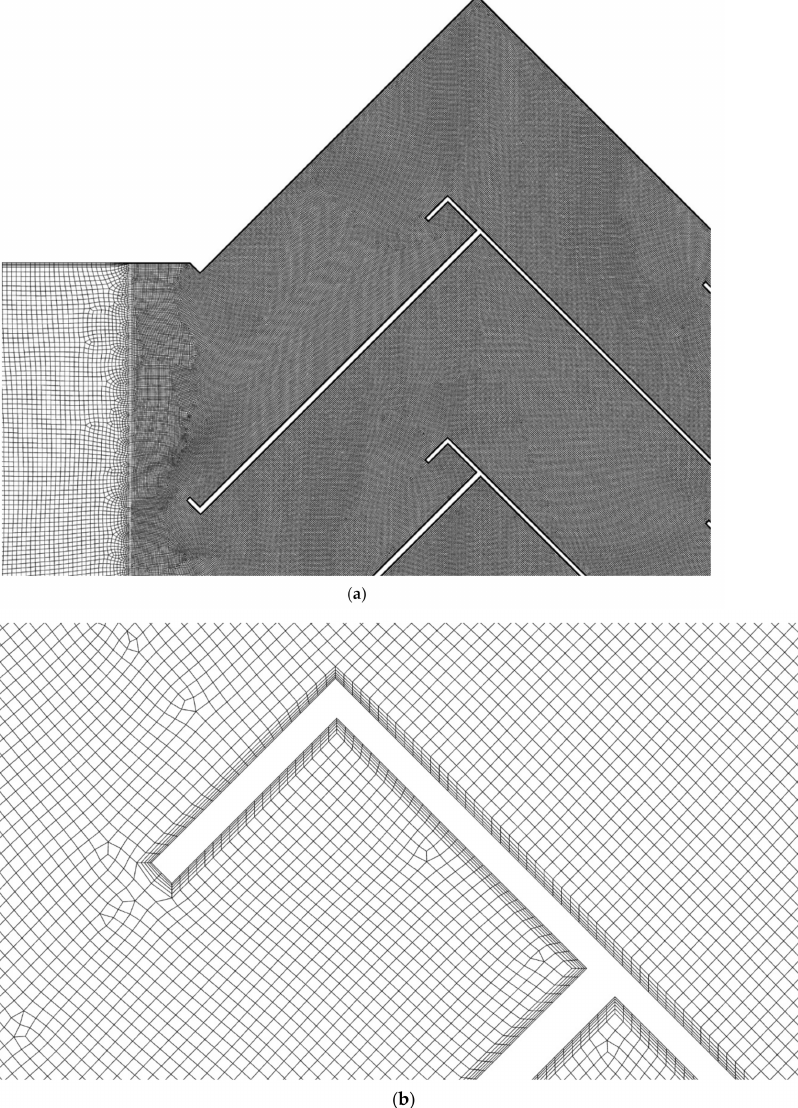
Figure 4. Final computational mesh of geometry B_10_0: ( a ) view on a fragment of mist eliminator; ( b ) detailed view on drainage